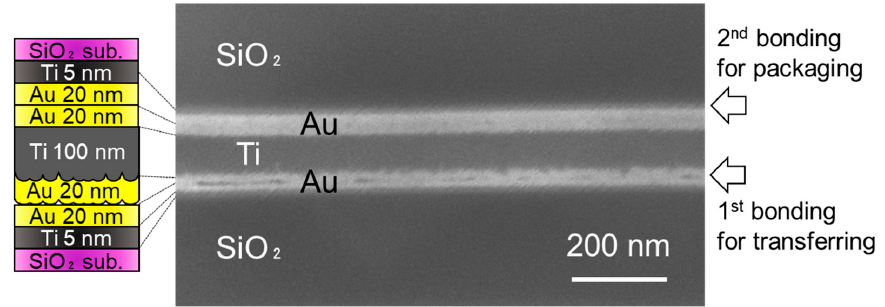
Figure 10. SEM image of the bonding interface. Sub-micro gaps were observed at the first bonding interface but not at the second one.